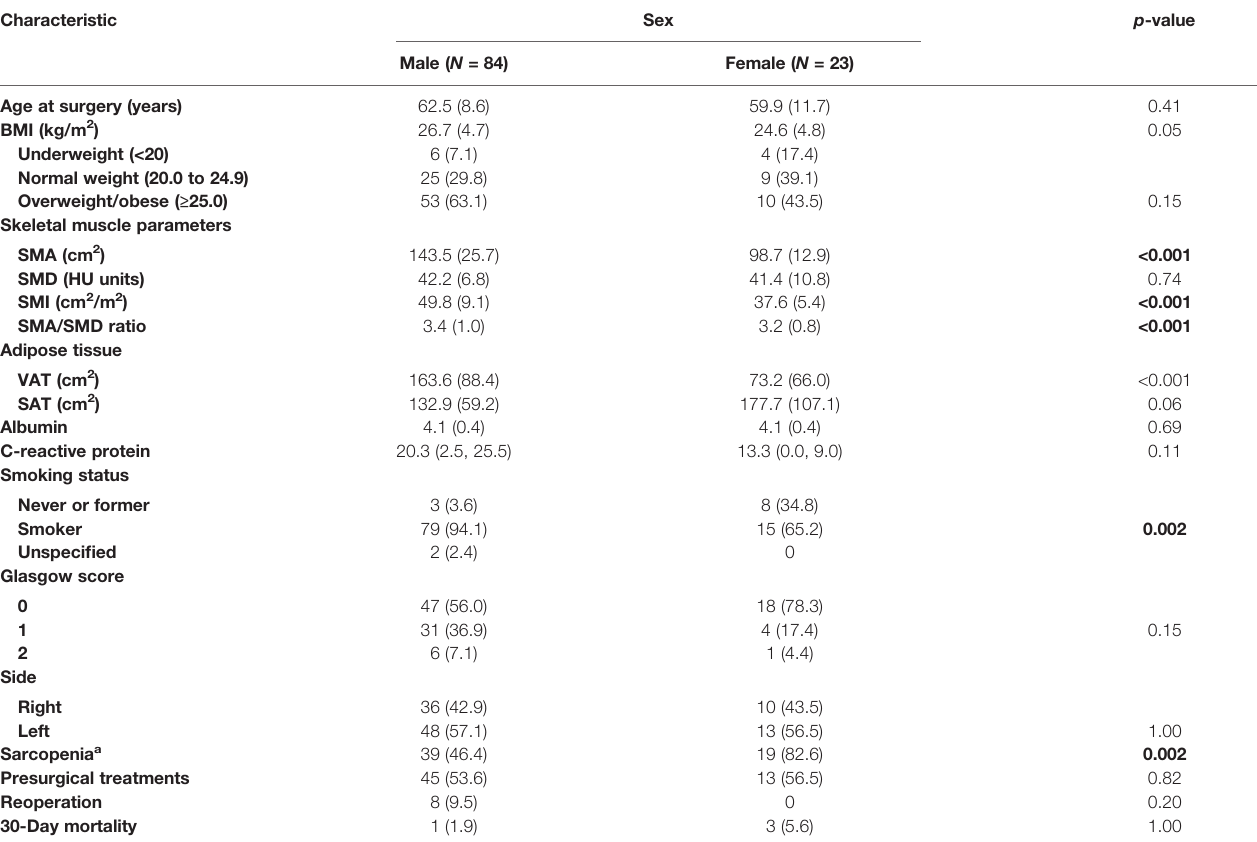
TABLE 2 | Comparison of patient characteristics by sex.